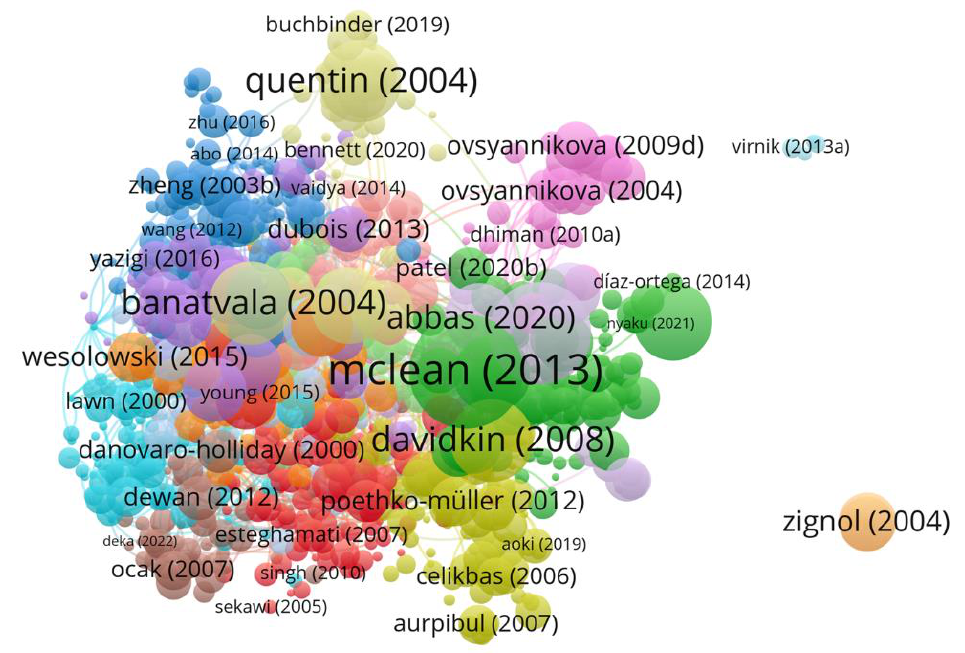
Figure 4. Most cited studies on rubella virus.